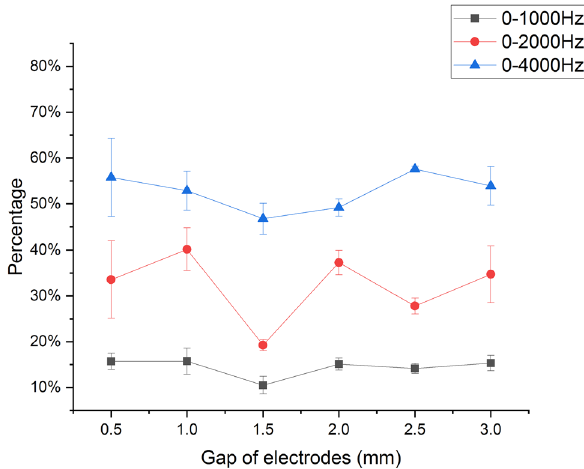
Figure 14. E � f / E versus